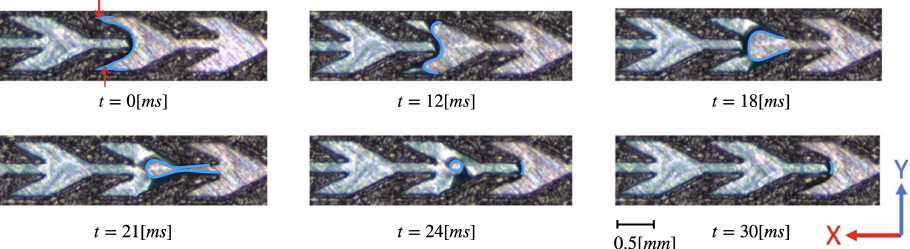
Figure 7. Evolution of water transport in channel type B in the negative direction. Experimental conditions are the same as in Figure 5. Water is colored in blue for better visibility and the triple line is highlighted by a bold blue line. Both red arrows for the panel at t = 0 [ms] indicates the presence of water in the tip of the